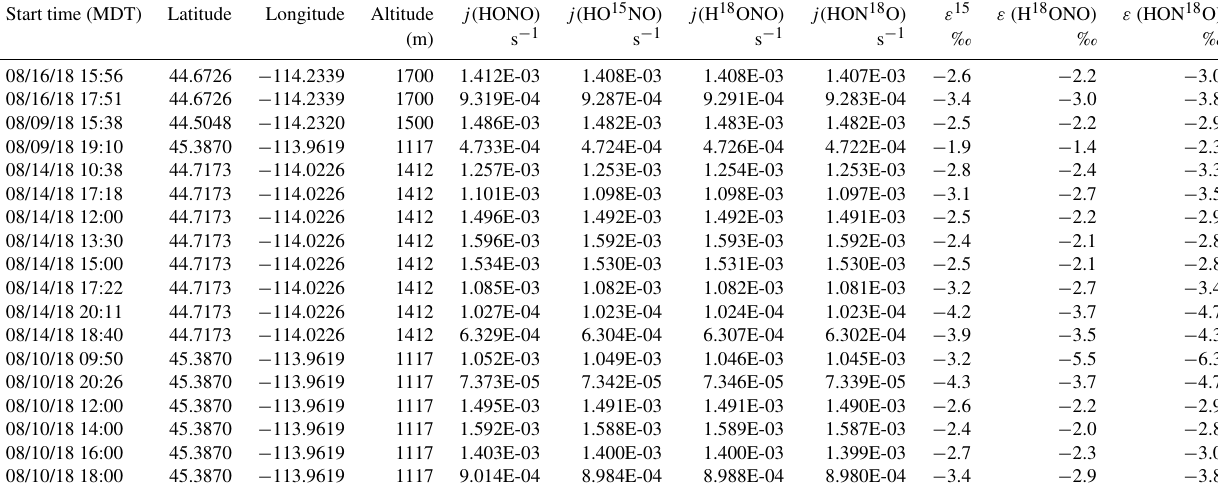
Table B2. Parameters used for TUV solar actinic flux modeling. The modeled enrichment coefficients for HONO photolysis for HO 15 NO, H 18 ONO and HON 18 O are presented in a data repository